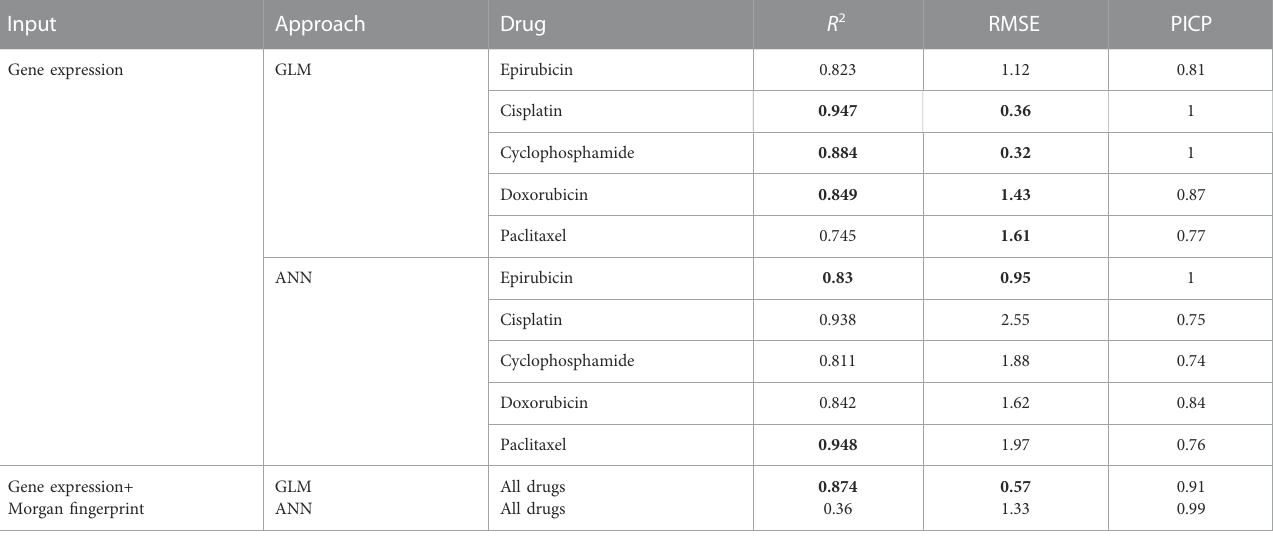
TABLE 2 Model performance evaluation. The bold values indicate the better results of the two approaches for each drug.